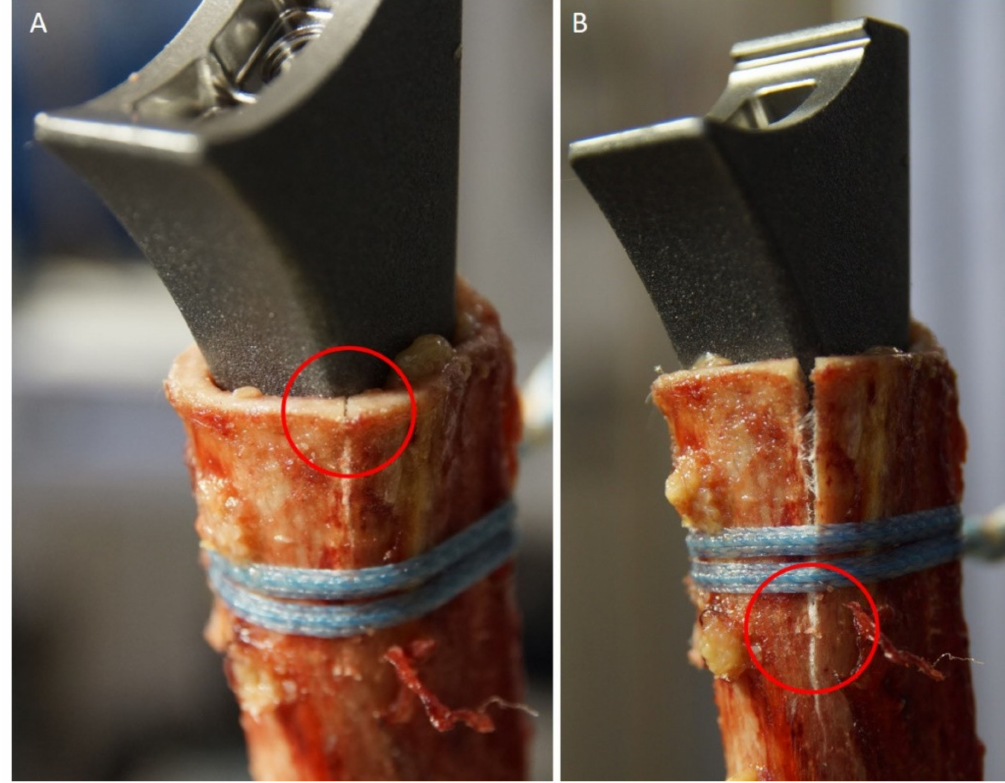
Figure 5. ( A ) First crack at the humeral shaft entrance. ( B ) Complete humeral shaft fracture progressing distally to the